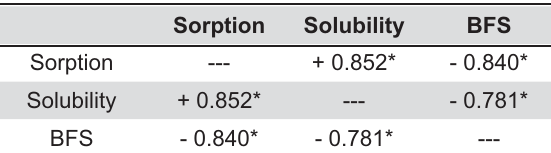
Table 5- (cid:2)?(cid:4)(cid:5)(cid:11)(cid:7)(cid:14)(cid:6)I(cid:7)(cid:2)(cid:2)!(cid:14)(cid:11)(cid:11)(cid:4)(cid:23)(cid:5)(cid:9)(cid:13)(cid:14)(cid:6)(cid:2)!(cid:14)(cid:4)(cid:20)K!(cid:13)(cid:4)(cid:6)(cid:9)